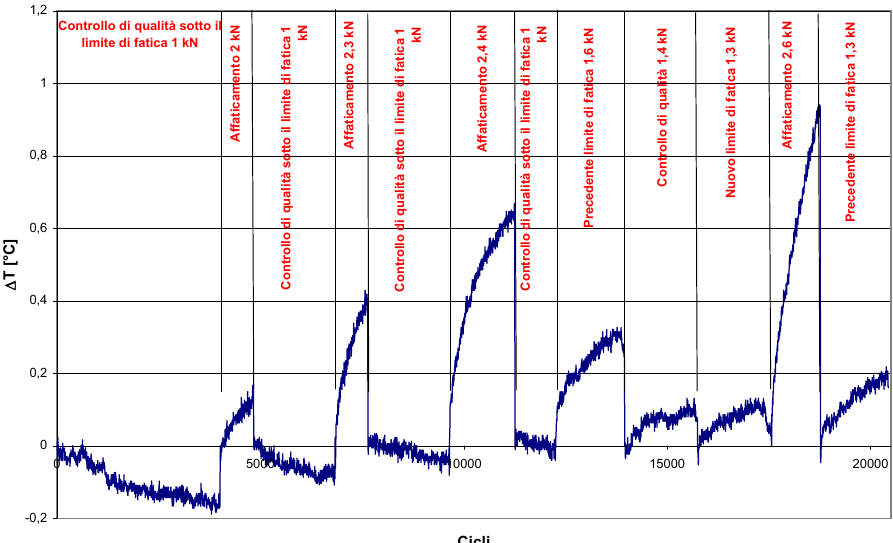
Figura 13: Sequenza di operazioni affaticanti e di valutazione del limite di fatica.